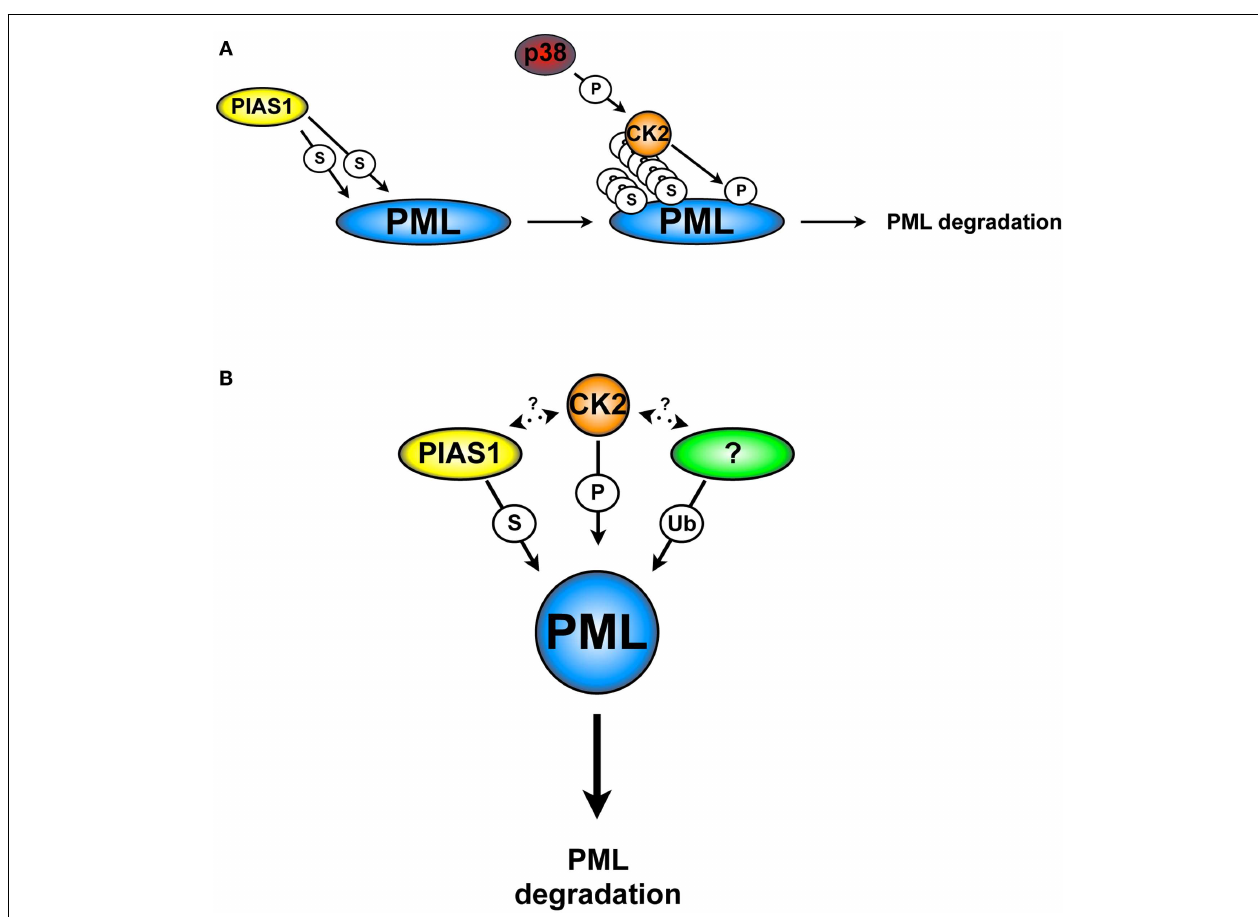
with CK2 and an unknown ubiquitin E3-ligase cooperate in order to lead to PML degradation. S, SUMOylation; Ub, ubiquitination; P, phosphorylation. Arrows indicate possible